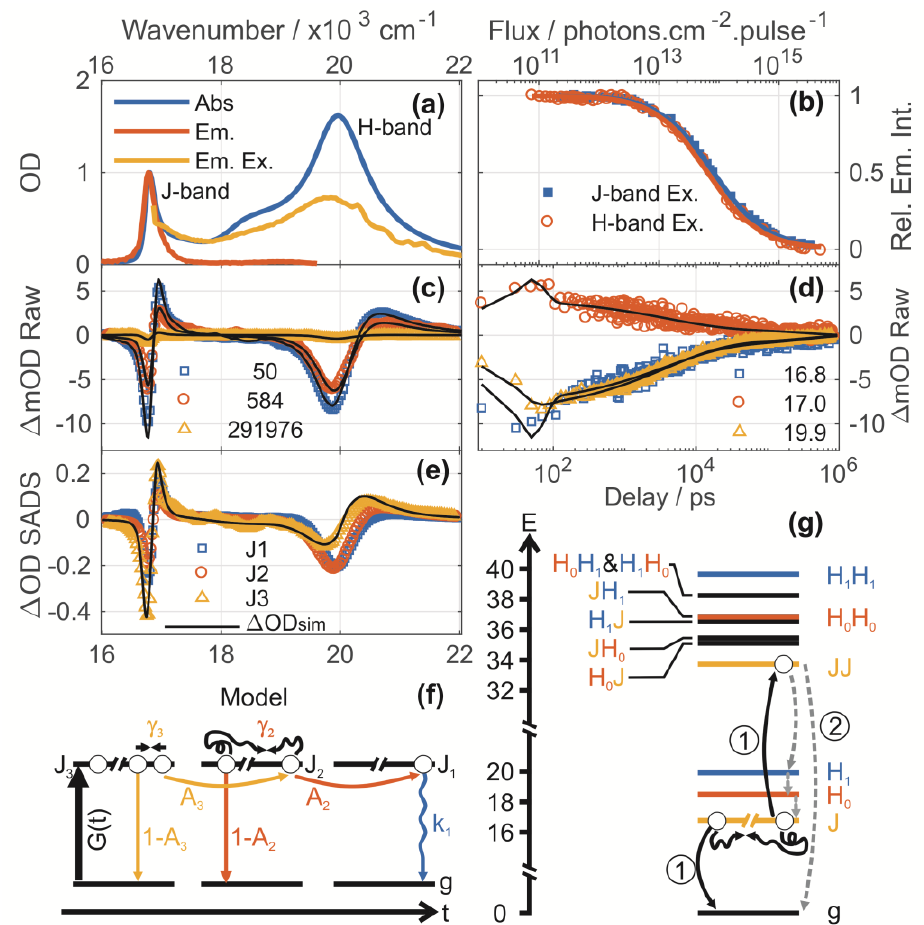
Fig. 1. a. TTBC isotropic absorption, fluorescence and fluorescence excitation spectra normalized to 100% conversion at ~17,000 cm -1 . b. Power-dependent emission intensity for J- and H-band excitation (square and circle). c. Transient absorption spectra for J-band excitation and horizontal probe at 50 fs, 584 fs and 292 ps (square, circle, triangle). d. associated time traces to c at 16,800, 17,000 and 19,900 cm -1 , corresponding to J-band bleach, excited state absorption and H-band bleach, respectively (square, circle, triangle). e. Retrieved state associated difference spectra (SADS) for a global fit to transient absorption and power-dependent fluorescence (solid lines in b, c and d ) data using the model depicted in f .  ODsim is an ideal difference spectra for pure J-band population, clearly, states J 2 and J 1 have additional positive signal to the blue of the J-band and additional H-band bleach, ascribed to H-band excited state population. f. Model used to globally fit TA and PDEm. data (See text for details). g. TTBC energy level diagram estimated from absorption and transient absorption data. Depiction of EEA processes of fusion (1) and relaxation to either lower states or ground